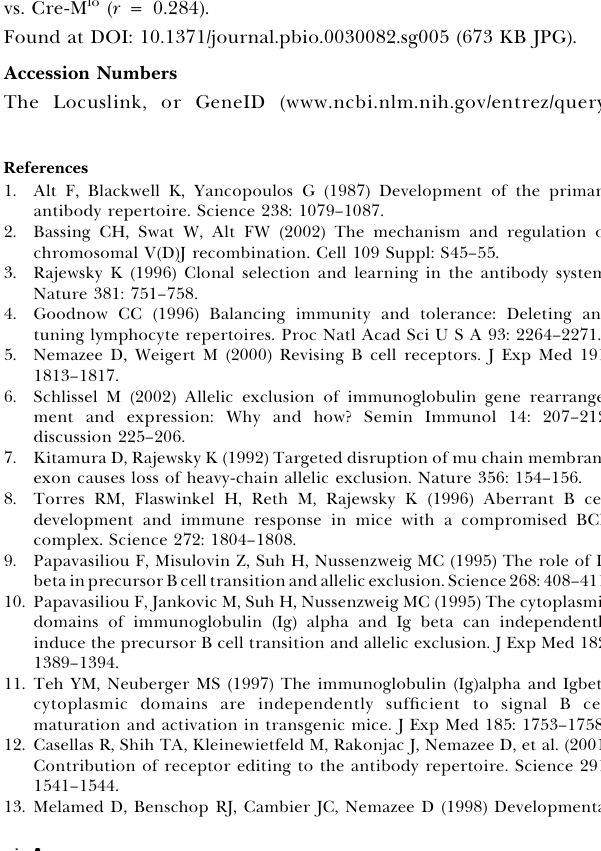
Figure S5. HEL-Ig/Mx-Cre Immature B Cells Fail to Back-Differ- entiate following IFN Treatment HEL-Ig mice were bred with Mx-Cre animals to generate HEL-Ig/Mx- Cre double transgenic mice. IL-7 BM cultures were established from two mice, and after 5 d IgM þ B cells were purified, washed, and then cultured for 2 d in 5,000 units/ml IFN. In parallel, a BM culture was established from a B1-8f/3-83 j /Mx-Cre mouse. After 2 d, cells were harvested, RNA was isolated, and cRNA probes were generated and hybridized to Affymetrix chips. Data analysis was performed identically to that described for Figure 2. (A) CD22 levels were measured by flow cytometry for the various cell populations after IFN treatment. (B) Shown are mean gene expression data for Ctrl-M hi ( n = 4) and Cre-M lo ( n = 4) samples for selected genes (see Figure 2 and Table 1). Fold differences were calculated as mean Cre-M lo /mean Ctrl-M hi . Also shown are the average raw data from the IFN-treated HEL-Ig/Mx-Cre samples ( n = 2), and the parallel IFN-treated B1-8f/3-83 j /Mx-Cre sample. Fold differences were calculated as IFN-treated B1-8f/3-83 j / Mx-Cre/HEL-Ig/Mx-Cre. Overall, the gene expression patterns of the HEL-Ig/Mx-Cre samples closely mirrored the Ctrl-M hi samples and showed no evidence for back-differentiation. In the same experiment, analysis of the cell surface profile and gene expression in HEL-Ig/Mx- Cre cells incubated with a PI3K inhibitor showed the expected back- differentiation response (data not shown), indicating that the HEL-Ig/ Mx-Cre cells were capable of the response. (C) Correlation coefficients were measured between the overall gene profiles of the two IFN-treated HEL-Ig/Mx-Cre samples compared with Ctrl-M hi and Cre-M lo mean values. Gene profiles of the IFN- treated HEL-Ig/Mx-Cre samples were significantly correlated with the Ctrl-M hi samples ( r = 0.655 and 0.637), and poorly correlated with the Cre-M hi samples ( r = 0.252 and 0.280), in the same range as Ctrl-M hi vs. Cre-M lo ( r =